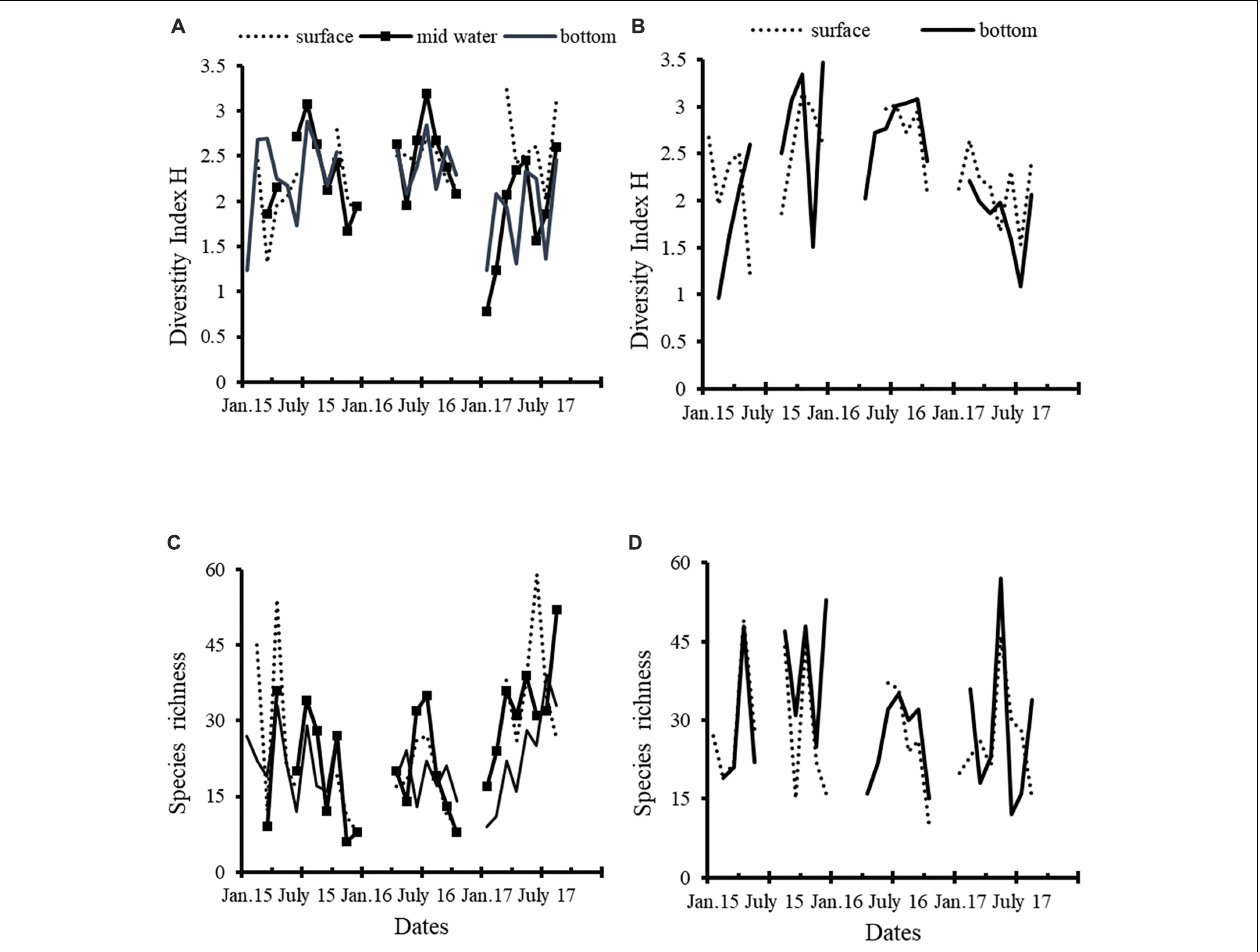
FIGURE 9 | Diversity index (Shannon-Weaver) and species richness in sampling stations E6 (left column) and E9 (right column). (A) E6 diversity index; (B) E9 diversity index; (C) E6 species richness; (D) E9 species richness.